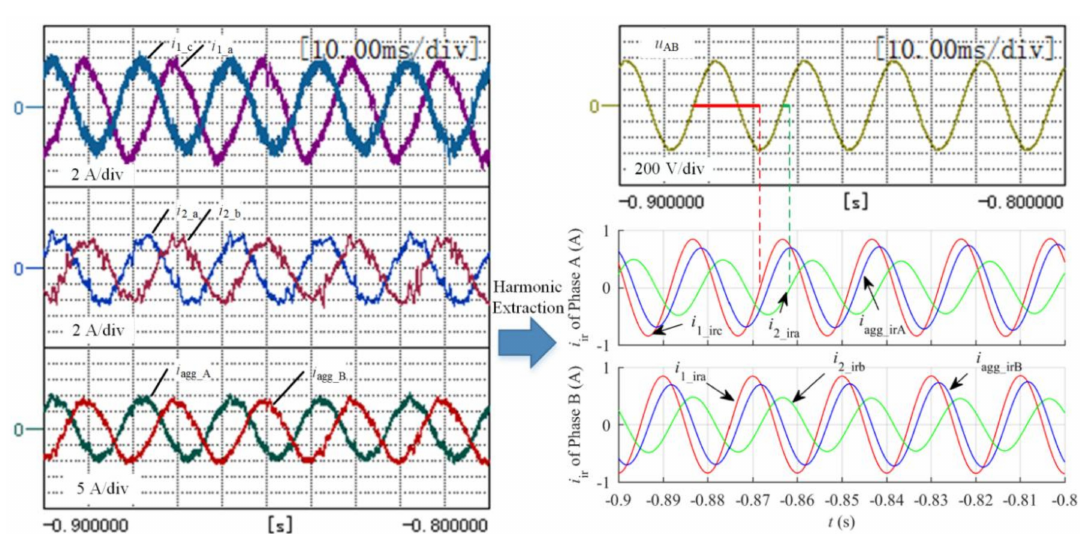
Figure 19. Actual negative sequence 50 Hz